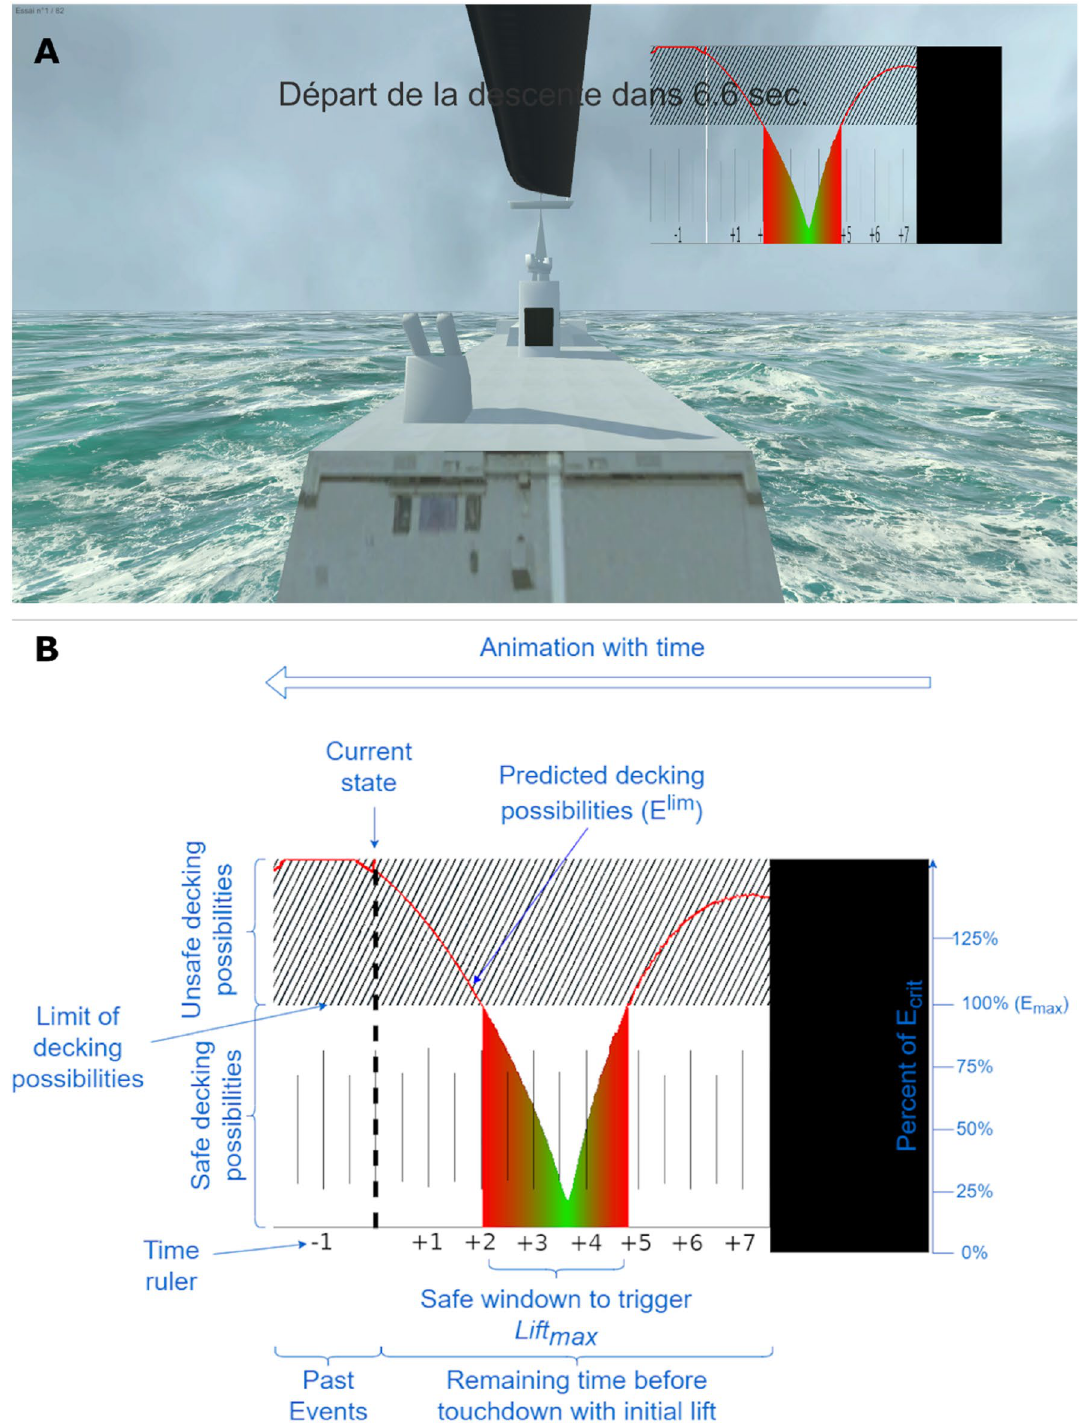
Figure 3. ( A ) Typical screenshot of the virtual scene during the hovering phase, including the frigate’s hangar, in front of which the ship’s deck was sitting, the top blade rotating at the top of the screen, and the Augmentation on the upper right part of the screen. The text, which was written in French, informed the participant that the initial descent was about to start in 6.6 s. ( B ) The visual Augmentation was designed to make visible the deck-landing-ability via the dynamics of the future touchdown velocity ( V td ) if L attempt was triggered. Annotations (not shown on the screen) are presented here in